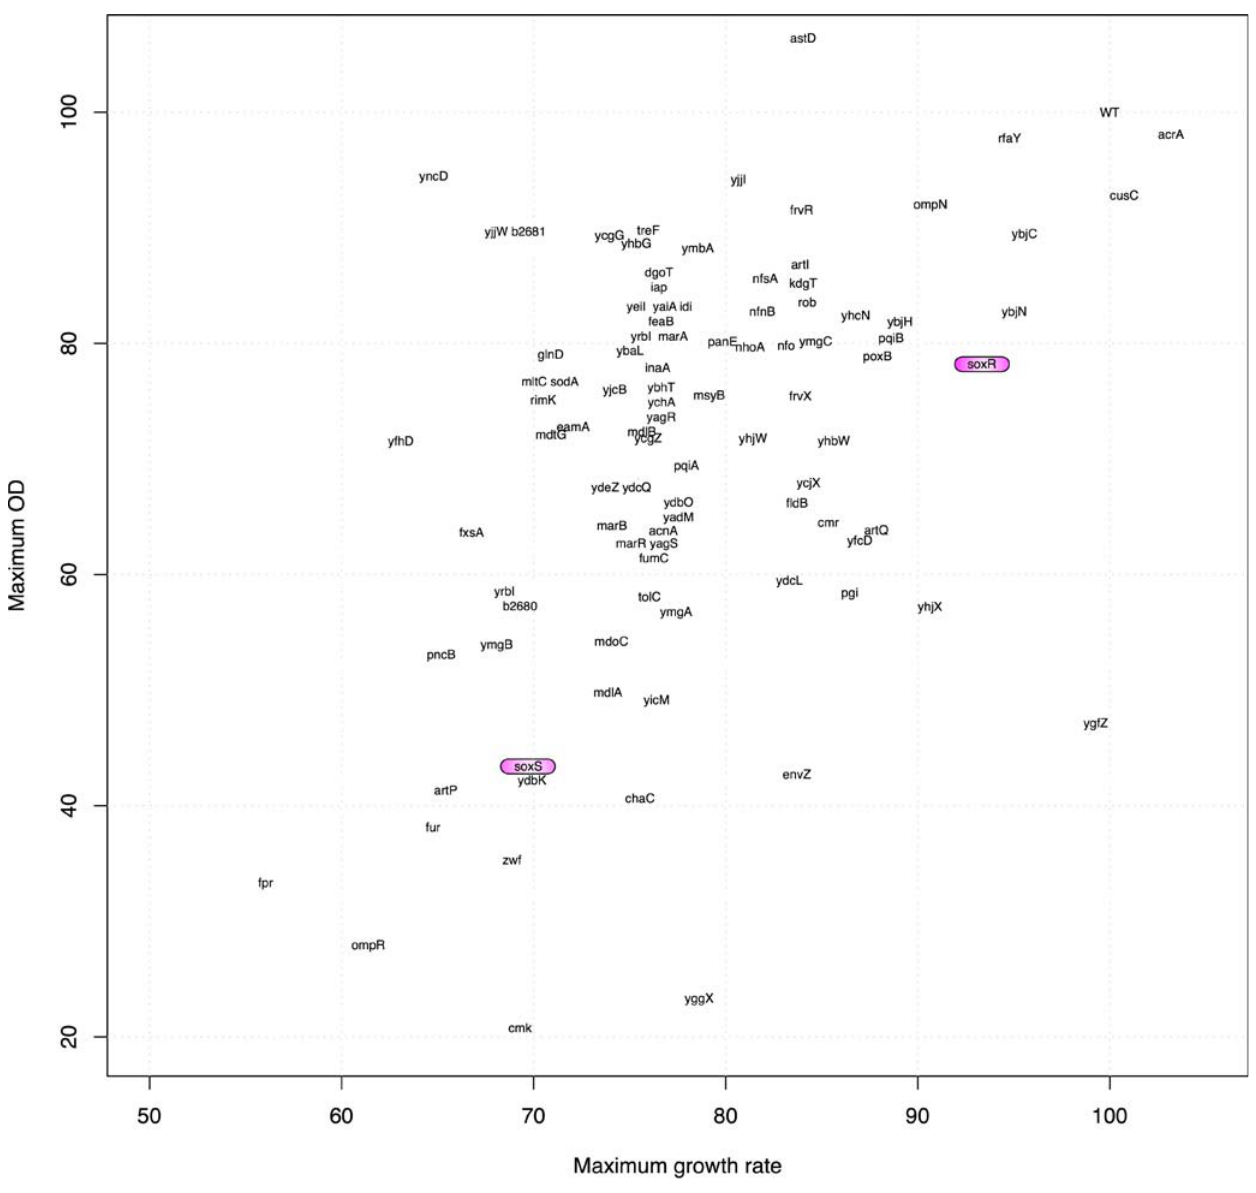
Figure 7. Effect of paraquat on strains carrying deletions in SoxR-modulated genes relative to the wildtype. The values represent the percent difference in final optical density and exponential growth rate in 94 precise deletion strains relative to the wild type in presence of paraquat normalized by the change in the deletion strains relative to the wild type in absence of paraquat. Therefore, a strain having wild type final optical density levels and exponential growth levels in the presence and absence of paraquat would have a value of 100 on both the x and y-axis. A minimum of six replicate growth curves were run for each deletion strain. The results for the D soxR and D soxS strains are circled. The following strains were not included because the corresponding genes are essential or are not part of the Keio collection: b1052, fldA, hemB, ligA, lpxC, map, mdl, ribA, rpoH, yadR, ygiA, yhbN, yraL , and yrbK .